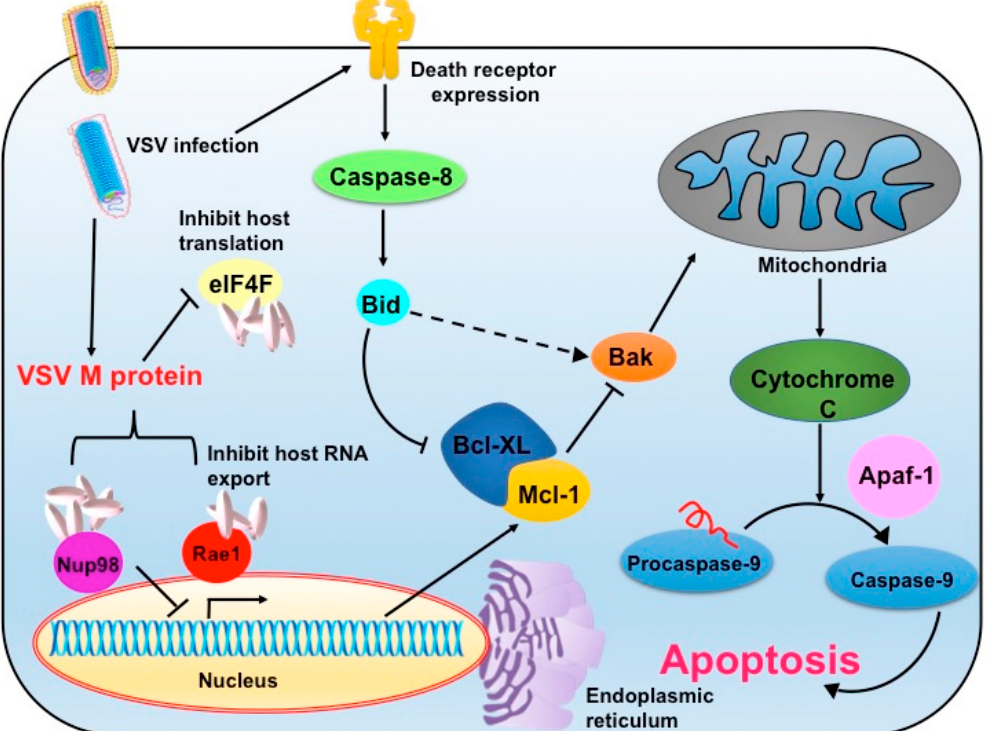
Figure 1. Mechanism of apoptosis induction by Vesicular stomatitis virus (VSV) in the infected